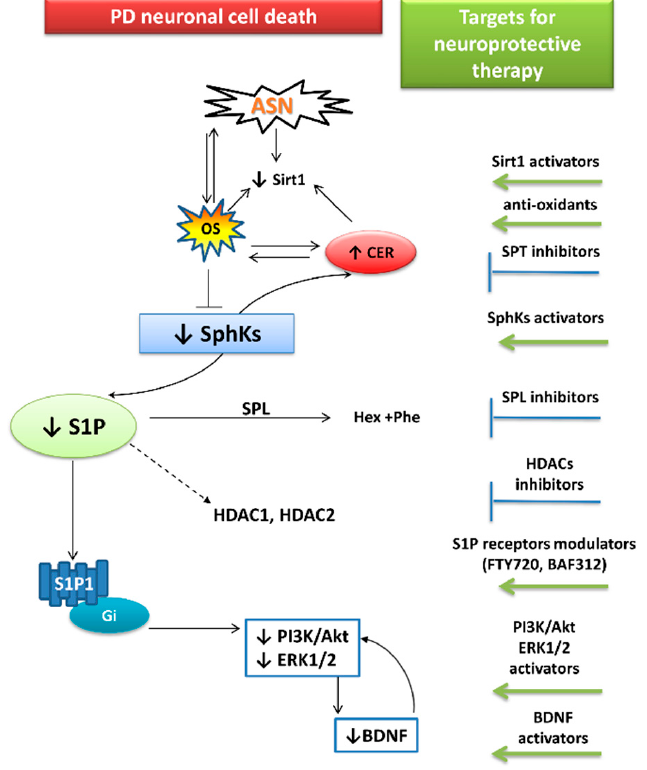
Figure 4. Potential targets for PD neuroprotective strategies associated with sphingolipid signaling and anti-oxidative defense. Arrows terminating with → represent activation, while those terminating with ┴ represent inhibition/deterioration. Abbreviations: PD-Parkinson’s disease; ASN—alpha- synuclein; Sirt1—silence information regulator 1 (sirtuin 1); OS—oxidative stress; CER—ceramide;